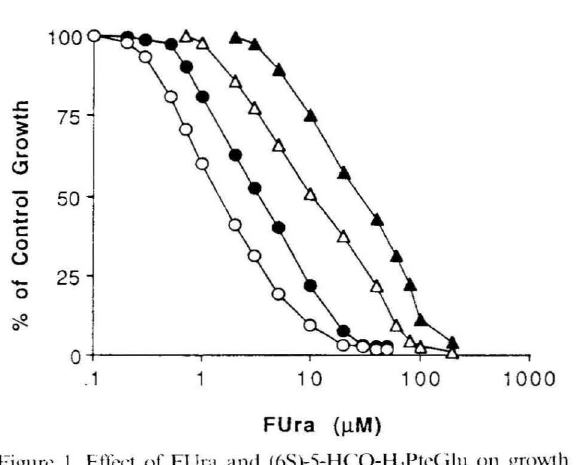
Figurc 1. FtTcct of FUra and (6S)-5-HCO-H.PtcGlu on grow1h of MCF-7 and MDA-MH 23 1 cells .. Experimcntal conditions were as d~scribed in Materials and Methods. MCJ-'-7 cells without (e) and with (,,) 5-HCO-H.PteGlu: MDA-MH ':231 cells without (& ) and with (I ,) )-HCO-H ,PtcC;lu. Points rcprc sent thc mean valuc of threc cxperiments in triplicate and the S.L are within the